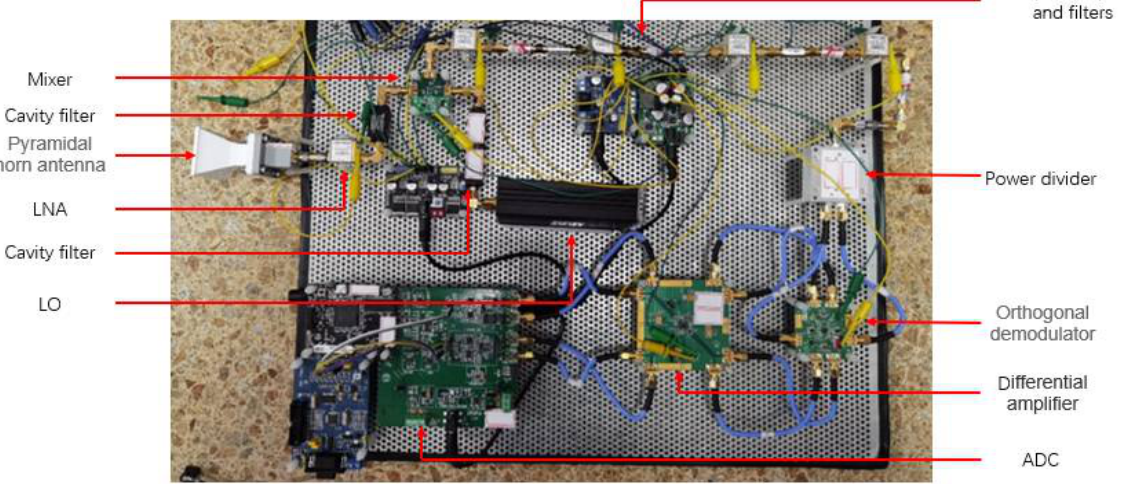
Figure 15. Prototype of novel interferometric microwave temperature-measuring radiometer.